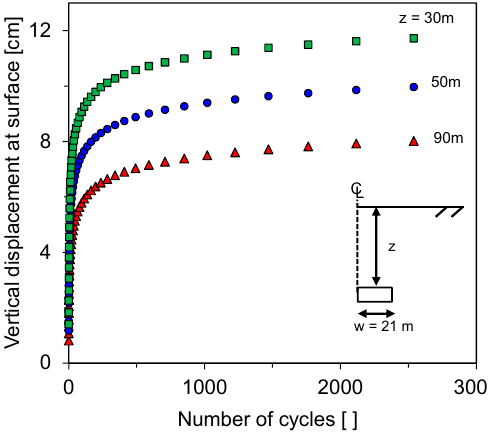
Figure 7. The effect of storage location on the displacement evolution. The case storage width w = 21 m and cyclic internal stress amplitude Δ P/P avg = 15%.